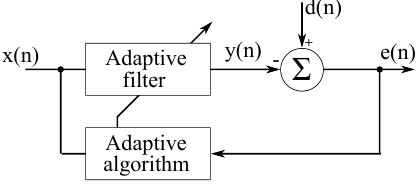
Figure 5. The structure of the adaptive